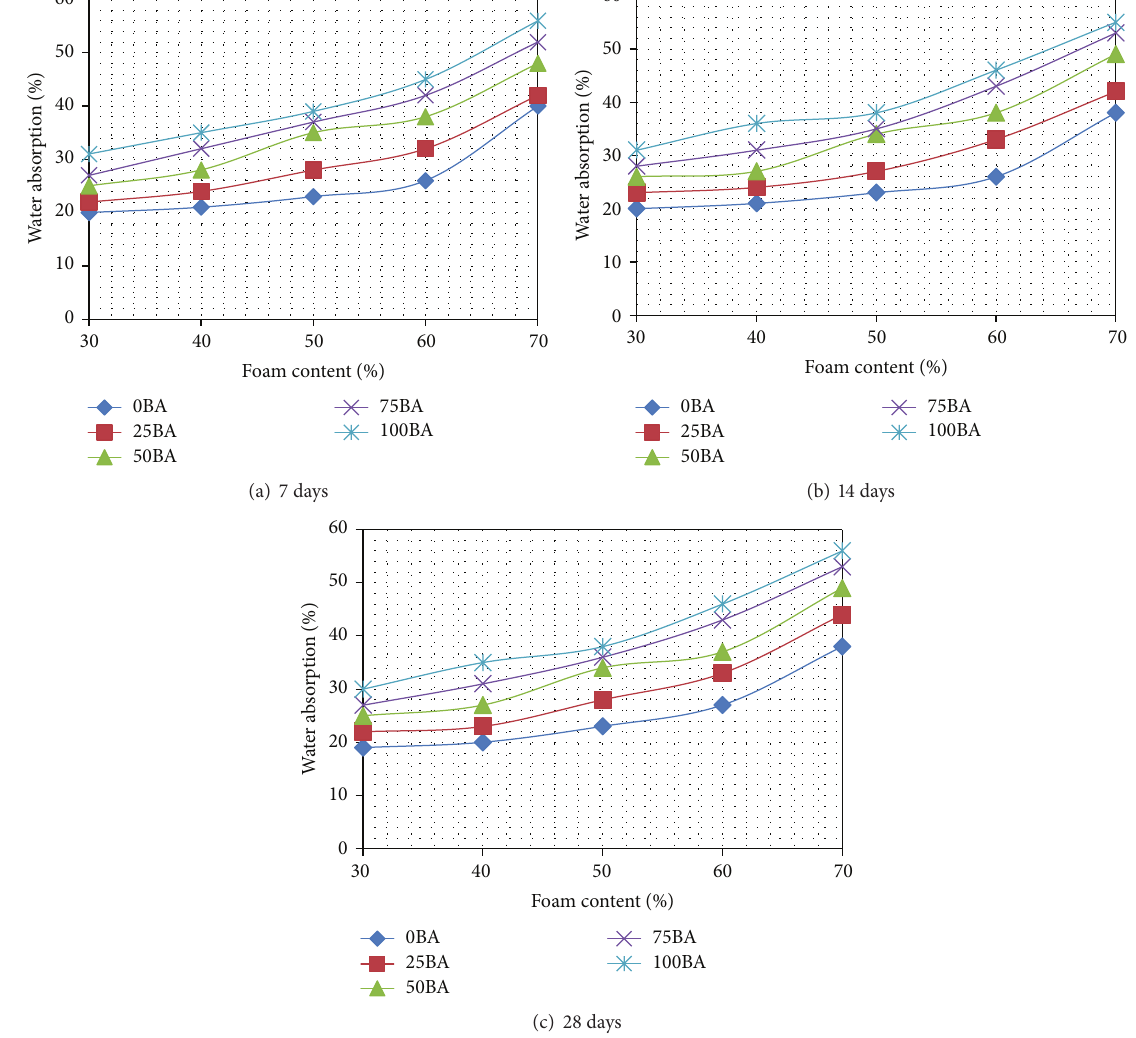
Figure 5: The water absorption of cellular